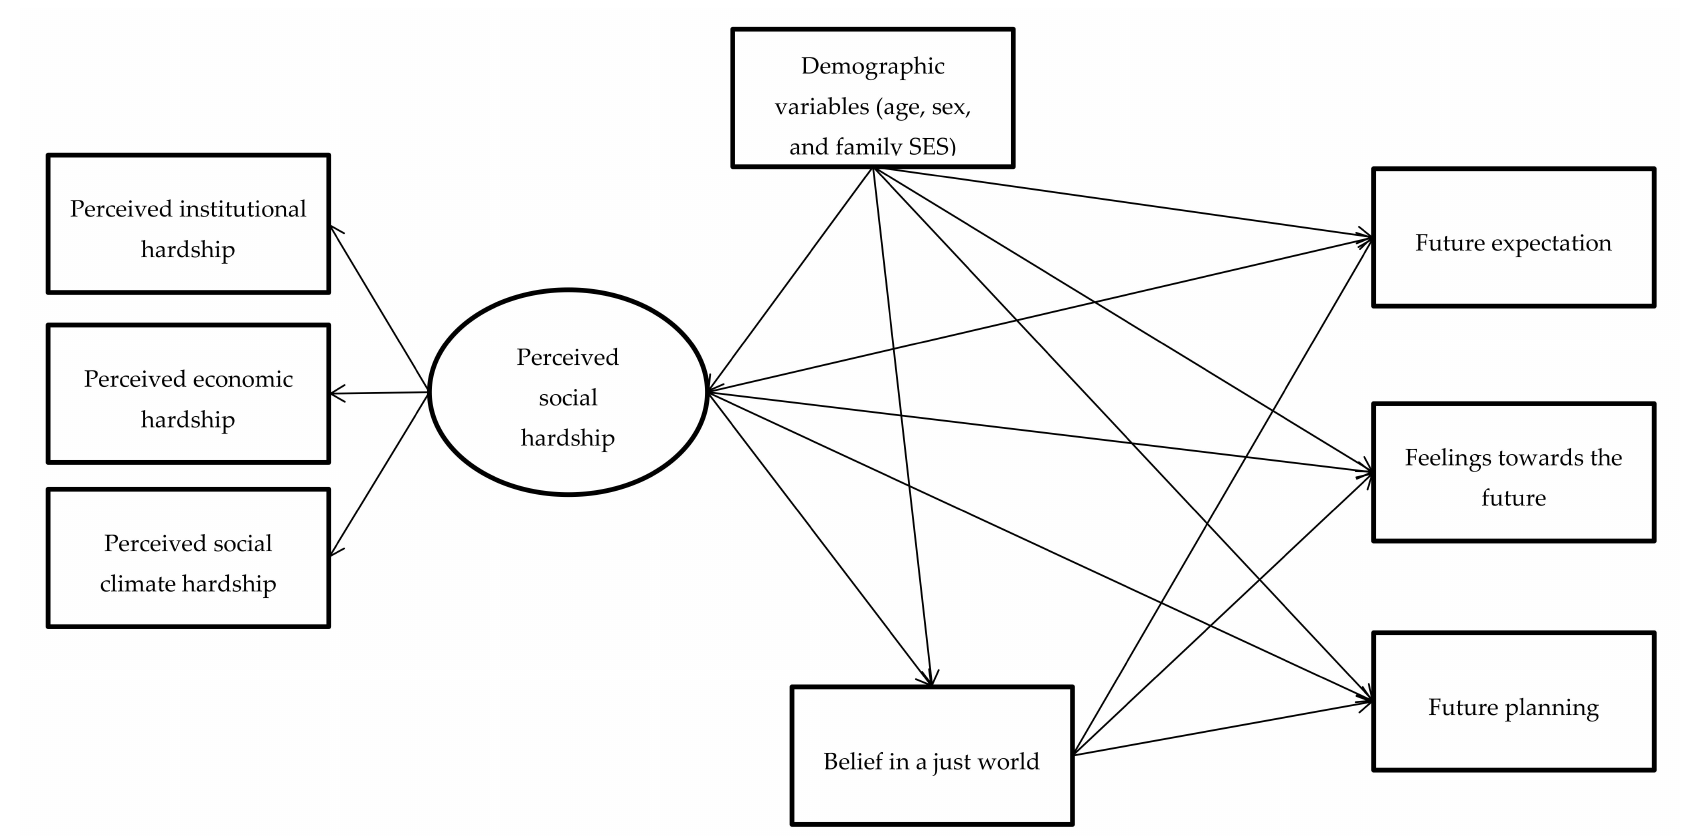
Figure 1. Conceptual mediation model of belief in a just world in the association between perceived social hardship and future